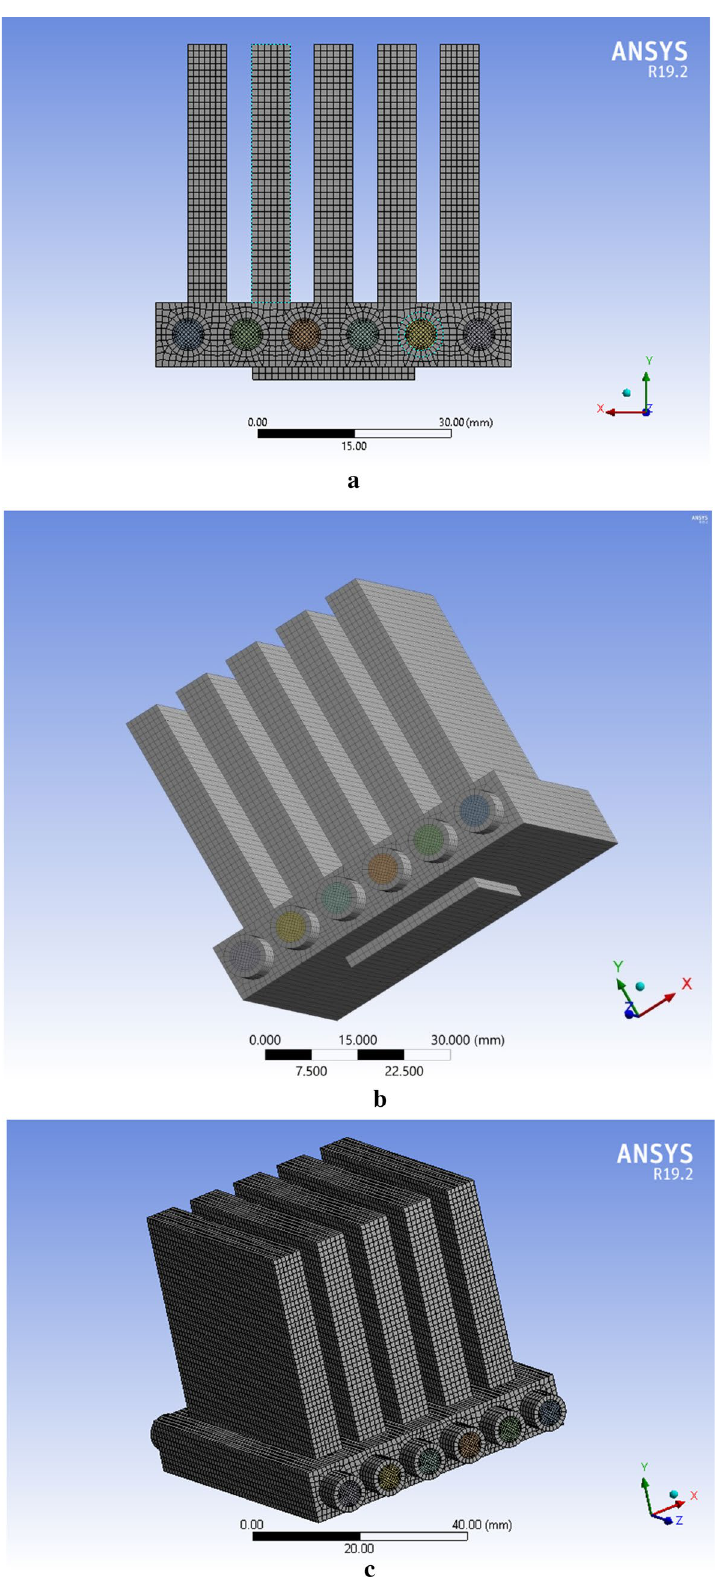
Figure 5. Computational mesh of the micropolar chip for cooling chip: ( a ) side view along the xy-plane, ( b ) bottom view, and ( c )